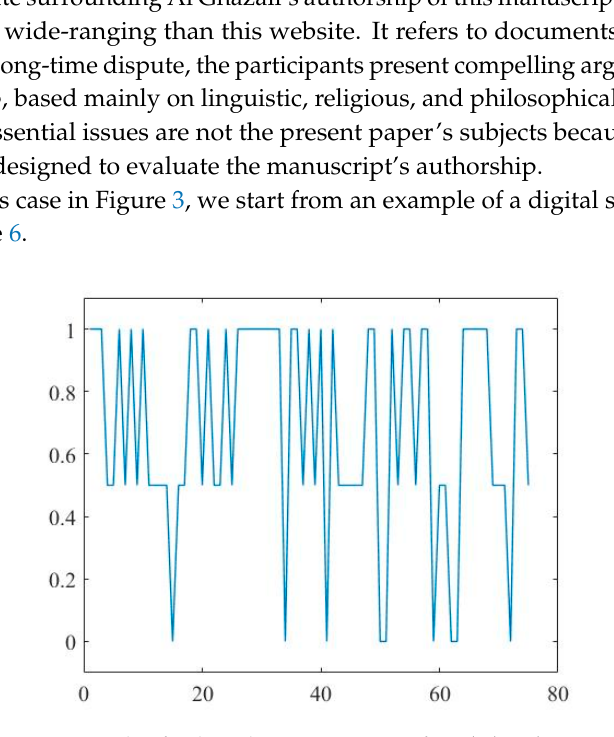
Figure 6. An example of a digital representation of Mishakat al-Anwar chunks.